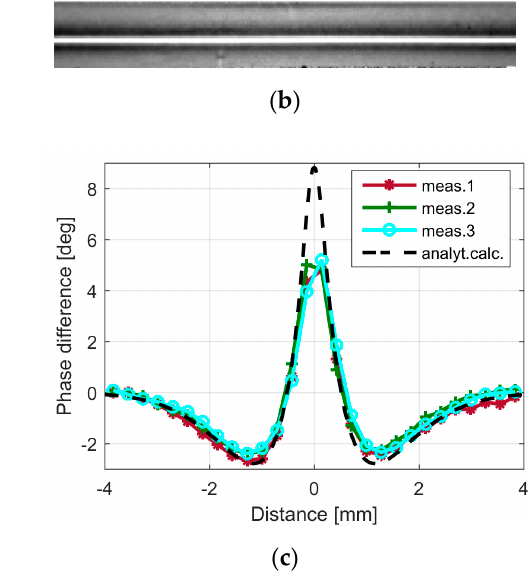
Figure 8. Microscopic image through the wire ( a ), a phase image ( b ), and measured phase profiles compared with the analytically calculated phase ( c ).